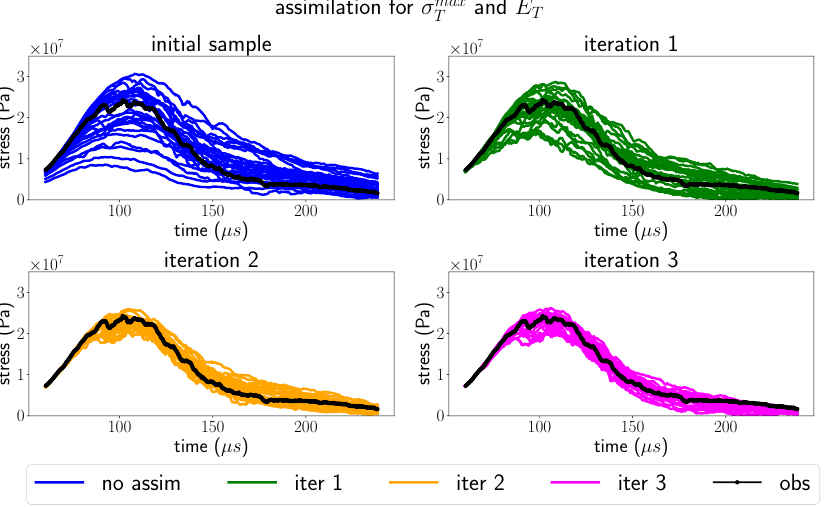
Figure 5. Time–stress curves of the reference simulation (black curve) and for each EnKF iteration, where each plot shows the evolution of the EnKF ensemble, starting with the initial ensemble of 25 members without assimilation (top left, blue curves), ensemble of the first EnKF iteration (top right, green curves), second iteration (bottom left, yellow curves), and third iteration (bottom right, magenta curves). At each iteration it is clearly seen how the EnKF iteration provides an ensemble that is getting closer or tighter around the reference